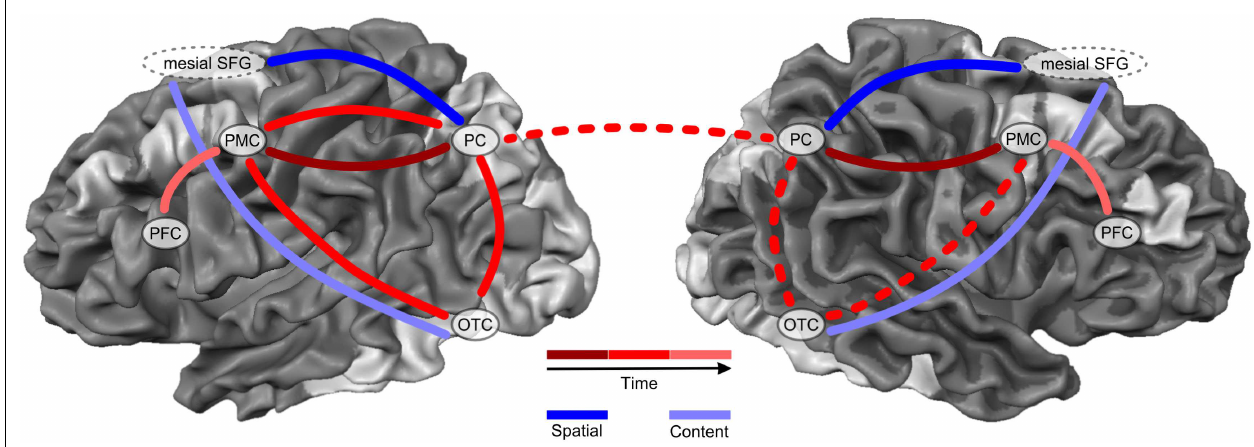
FIGURE 2 | Dynamic network model of spatial imagery. This figure depicts the here proposed dynamic network model of spatial imagery. Spatial imagery consistently activates several nodes within both, the dorsal fronto-parietal as well as ventral occipito-temporal visual processing pathway (silver-shaded areas). Most prominent regions within the dorsal pathway during spatial imagery include bilateral PC, Parietal Cortex; PMC, Premotor Cortex; and PFC, Prefrontal Cortex. Likewise, most prominent regions of the ventral pathway activated during spatial imagery are located along the Occipito-Temporal-Cortex (OTC), and include inferior temporal regions and parahippocampal cortex, but also superior occipital areas and in some conditions even primary visual cortex (silver-shaded areas). During spatial imagery, these two pathways can be labeled as representing the CONTENT (curve color-coded in light blue) versus SPATIAL (curve color-coded in dark blue) aspects of spatial imagery.The areas within the fronto-parietal dorsal network dynamically exchange information during spatial imagery with a direction of information flow from anterior frontal/premotor regions to posterior parietal cortices. An early bilateral PMC-PC (solid curve color-coded in dark red) can be segregated from a